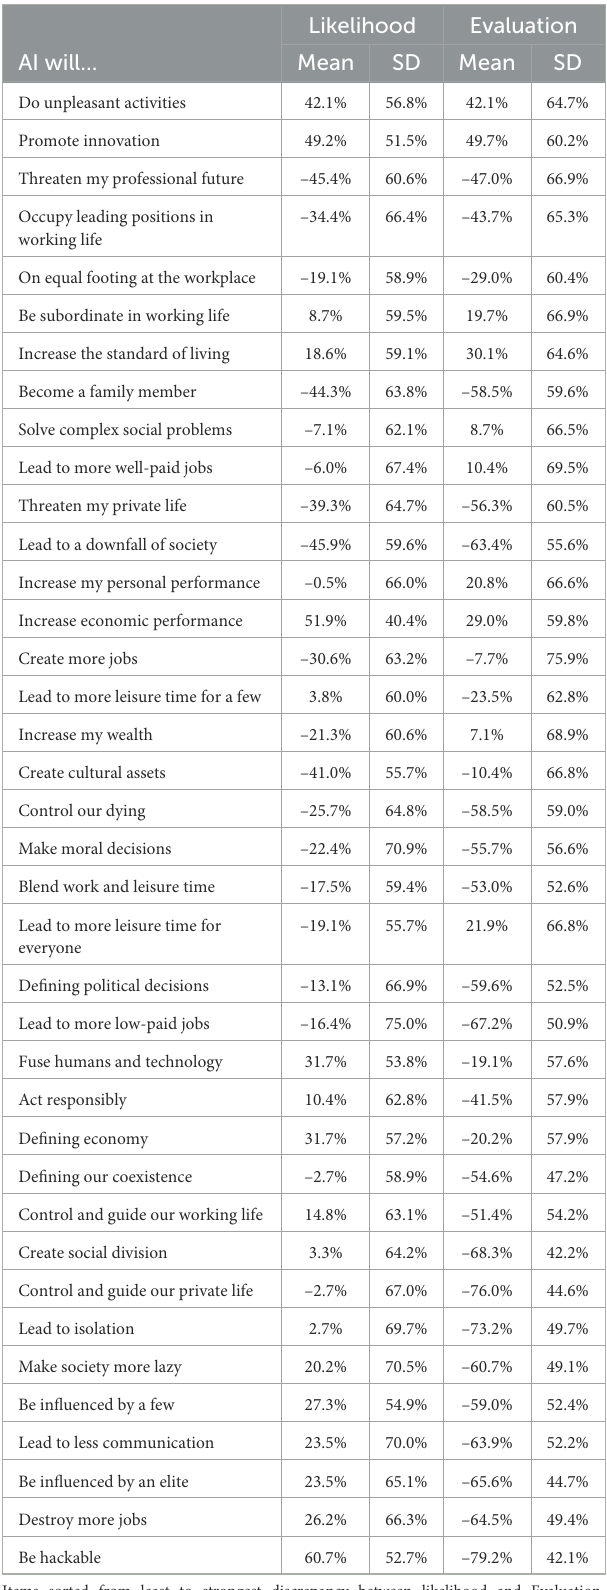
TABLE 2 The participants’ estimated likelihood (Likelihood) of occurrence and subjective assessment (Evaluation) of the various consequences AI could have on our lives and work a .